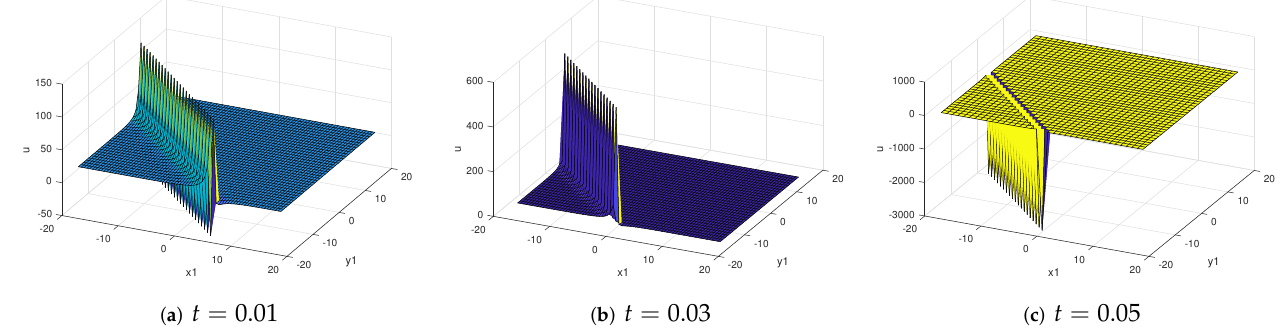
Figure 1. Exact solutions in Equation (53) at different time with α = 0.9, α 1 = 1, β = 0.5, γ = 1, δ = 0.5, λ = 1.5, µ = 0.5, ε = 85.746, a 0 = 1, c 1 = 1, c 2 = 2, x 2 = 9.7, y 2 =